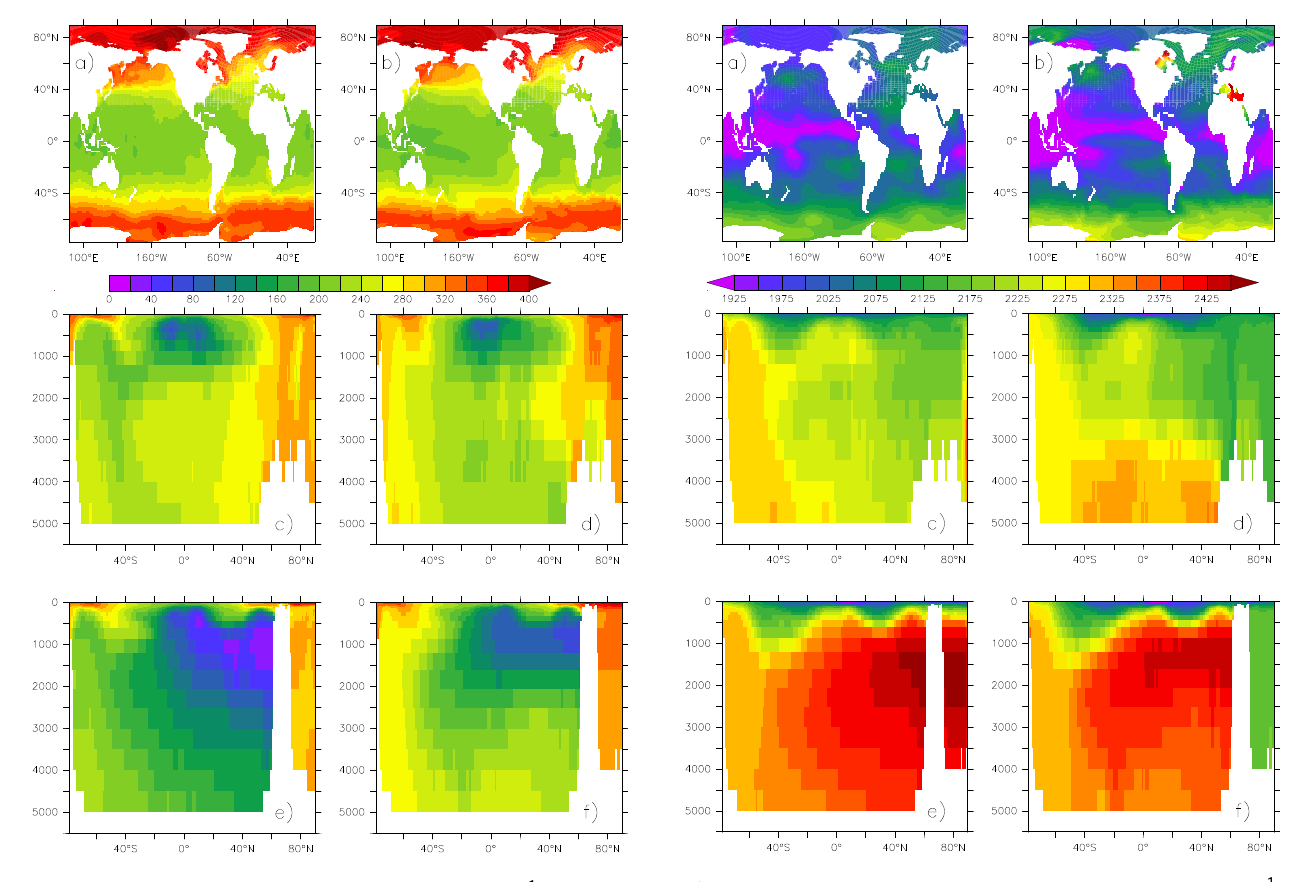
Figure 11. Annual-mean O 2 concentrations in µmolL − 1 . Observa- tions are from the World Ocean Atlas 2009 (Garcia et al., 2010). Panels are the same as on Fig. 9.